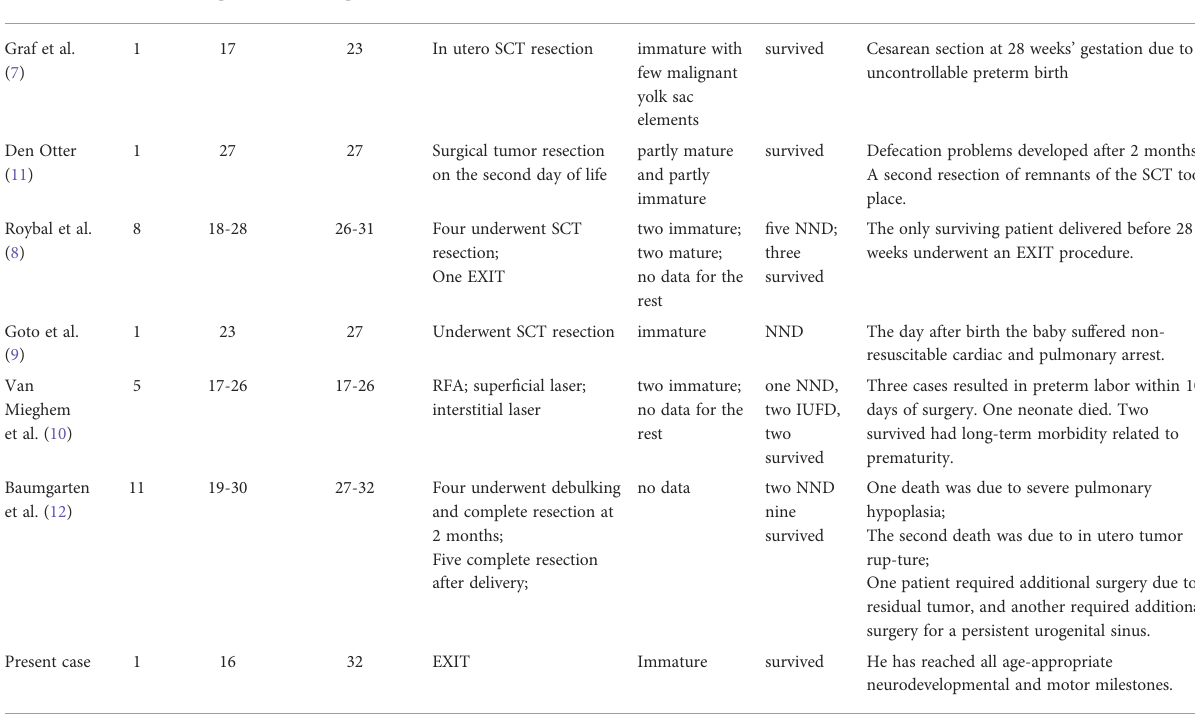
TABLE 2 Overview of literature review of SCT with cardiac insuf fi